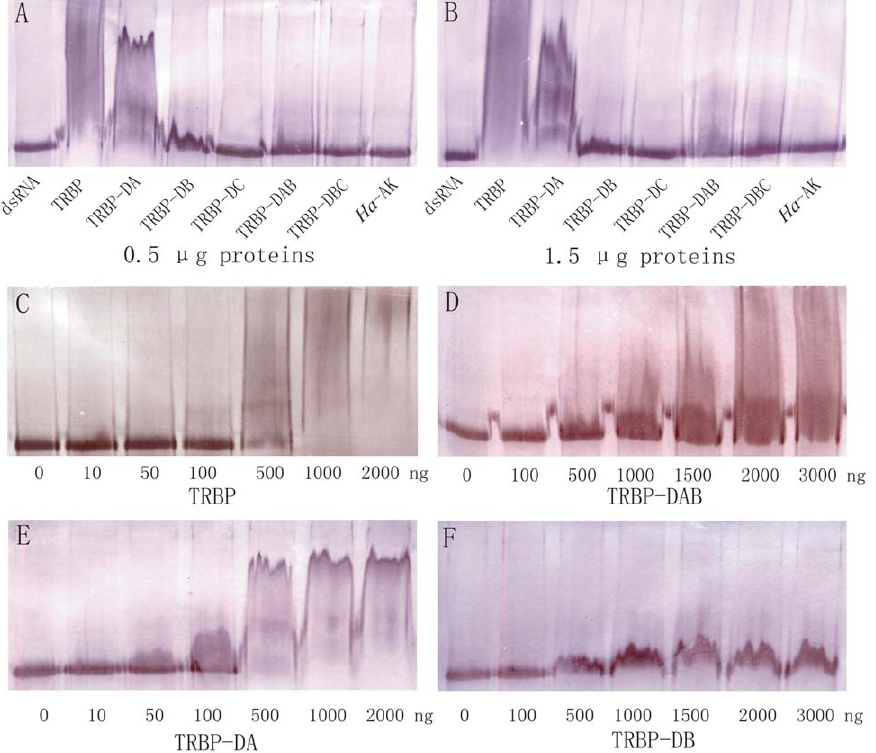
Figure 3. Gel-shift assays that identify the dsRNA-binding activity of recombinant dsRBDs of Mj -TRBP and full length recombinant Fc -TRBP. A, B: 0.5 m g (A) and 1.5 m g (B) recombinant protein were incubated with 2.5 m g dsRNA (802 bp). Ha -AK served as control. C, D, E, F: Increasing amounts of recombinant protein (TRBP, TRBP-DAB, TRBP-DA, and TRBP-DB) were added and incubated with 2.5 m g dsRNA; the number under each lane represents the amount of recombinant proteins added to the dsRNA. Fc -TRBP and dsRBD A of Mj -TRBP could bind to dsRNA with high affinity. The affinity of dsRBD B was very weak. dsRBD C was unable to bind to dsRNA.